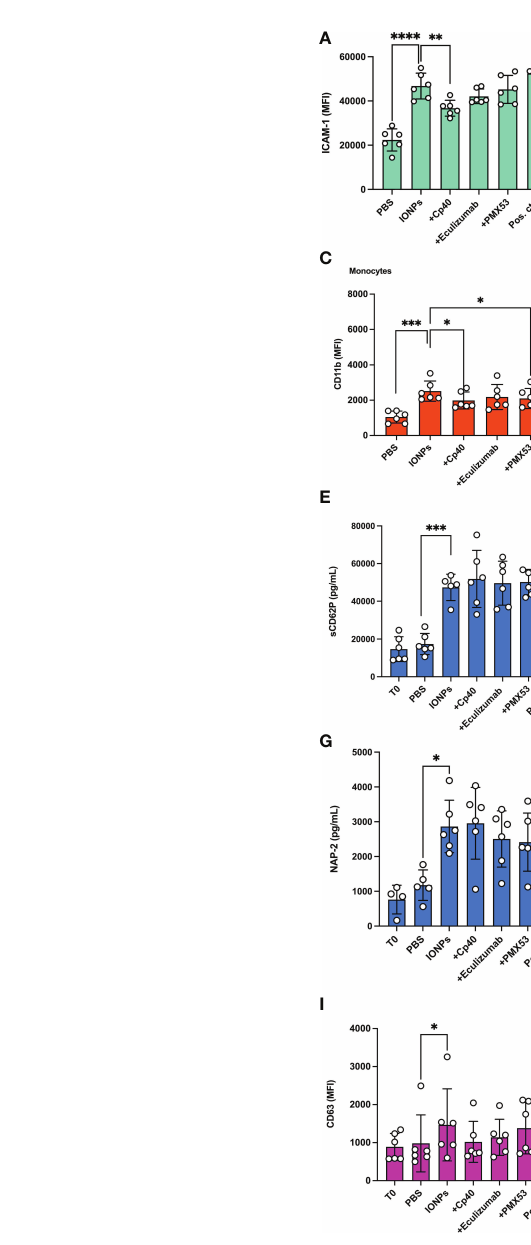
FIGURE 4 IONPs-induced endothelial cell-, monocyte-, granulocyte- and platelet activation. Human whole blood was incubated together with HLMECs and a mixture of IONPs (100 m g/mL) of different sizes; 10, 20, and 30 nm in the presence of inhibitors; Cp40 (20 m M), eculizumab (100 m g/mL) or PMX53 (10 m g/mL) for four hours at 37°C. Zymosan (100 m g/mL) and LPS (10 ng/mL) served as a positive control (Pos. ctrl) for endothelial cells and monocytes, respectively. PBS was used as a negative control (PBS). Endothelial cell activation was evaluated by measuring ICAM-1 (A) and CD62P/E (B) expression by fl ow cytometry. Cell surface activation marker CD11b was measured on monocytes (C) and granulocytes (D) by fl ow cytometry. Plasma was analyzed by ELISA for soluble markers of platelet activation; sCD62P (E) , PF4 (F) , and NAP-2 (G) . Additionally, PRP was isolated from the same donors and incubated separately under the same experimental conditions for 15 minutes. TRAP-6 (25 m g/mL) was used as a positive control (Pos. ctrl) and PBS as a negative control (PBS). Cell surface activation markers CD62P (H) and CD63 (I) and C3c fragment deposition (J) were measured on platelets by fl ow cytometry. The values are shown as mean +/- standard deviation of n=6. *p<0.05, **p<0.01,***p < 0.001,